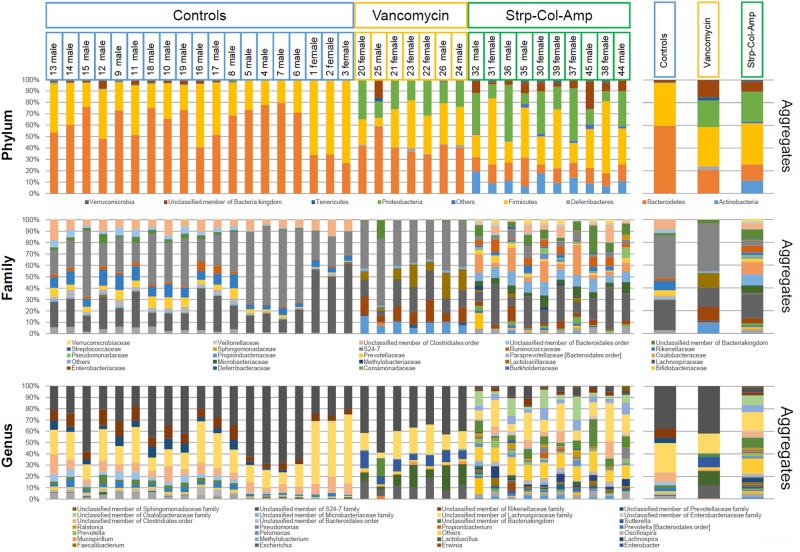
Microbiota composition of control and treated mice at phylum, family and genus levels.The bar plots show the microbiota composition at phylum, family and genus levels of the 36 mice fecal samples analyzed by 16S rRNA profiling, divided by treatment. On the right side three bar plots show the aggregate (average) bacterial composition of the three treatment conditions. Only taxa with relative abundance > 2% in at least one sample are shown.